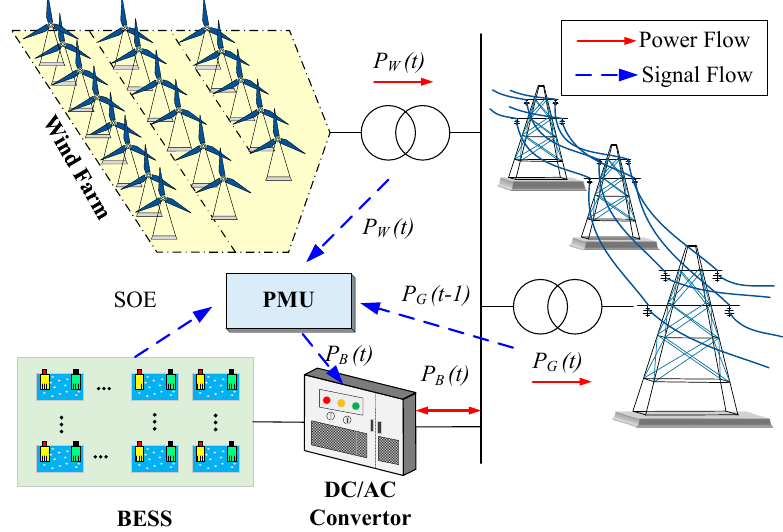
Figure 1. Structure chart of wind/battery energy storage hybrid system. P G ( t ) : Grid-connected power at time t , P W ( t ) : Wind farm output power at t , P B ( t ) : Output power of energy storage